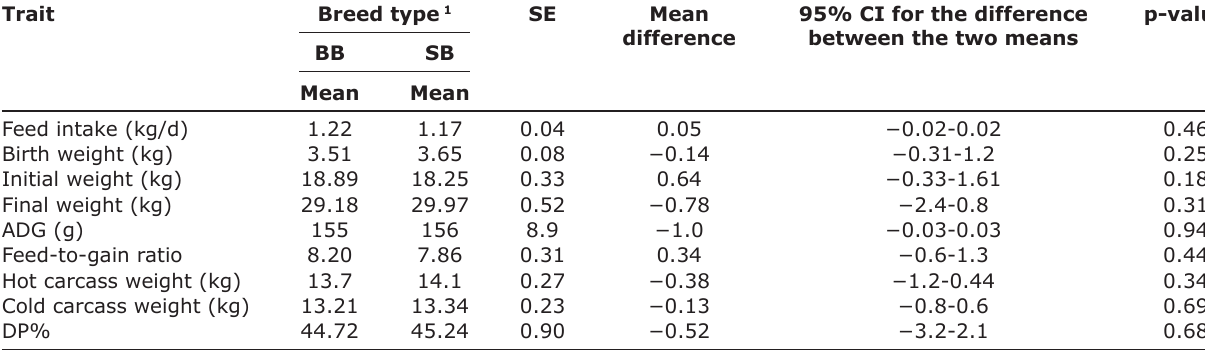
Table-1: Means, SE, and 95% CI for the difference between the means for growth performance BB and SB kids. Trait